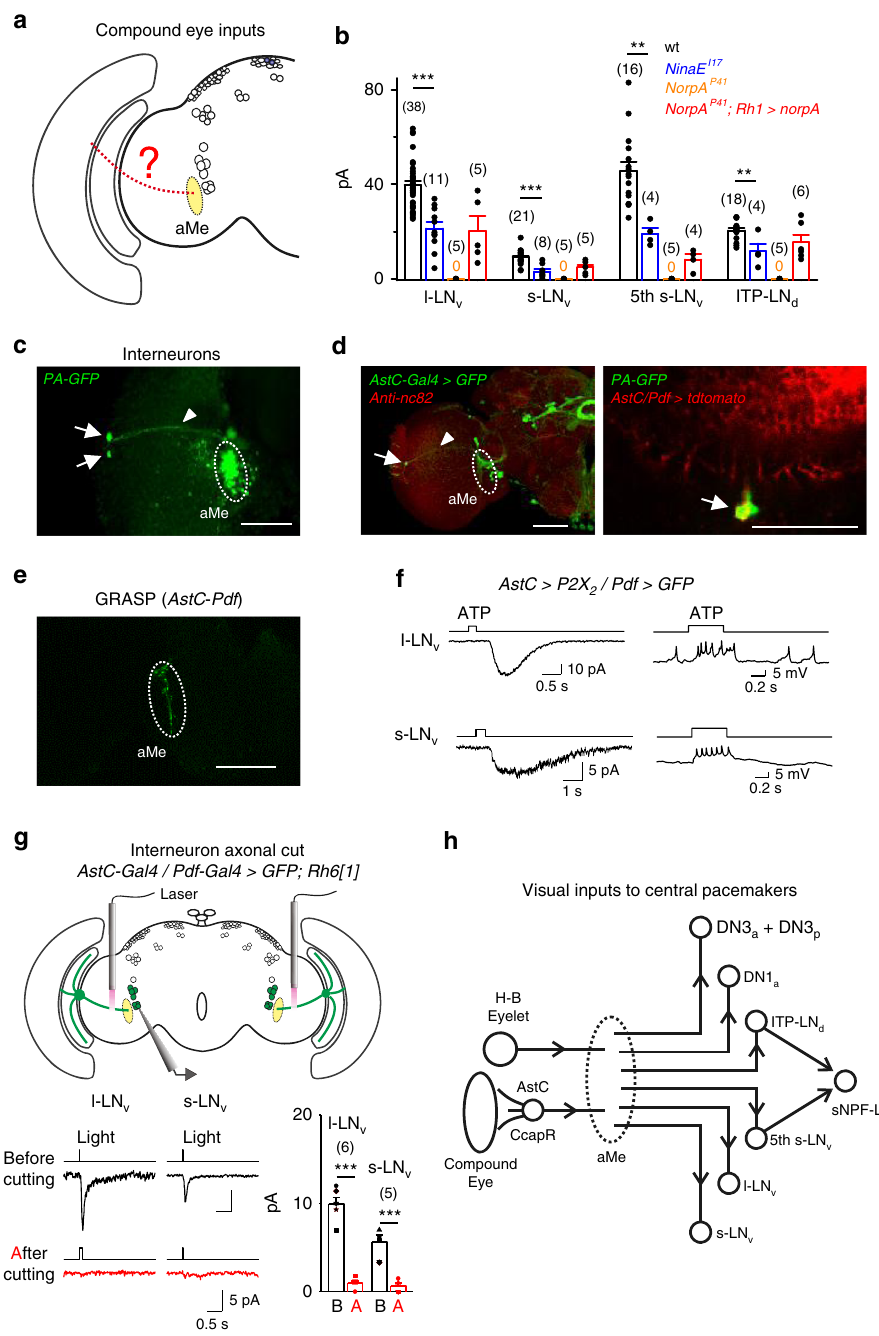
Fig. 7 AstC/CcapR interneurons relay compound-eye inputs to the clock. a Schematic illustration of compound-eye inputs to the central pacemaker neurons. b Collective data of light responses in pacemaker neurons of the different fl ies as indicated. Cell numbers are indicated in brackets; error bars represent SEM; ** P < 0.01; *** P < 0.001. c Interneurons connecting compound eyes to pacemaker neurons. Two interneurons (marked by arrows) are PA- GFP-labeled after two-photon photoactivation of the aMe. d AstC interneuron labels one PA-GFP interneurons. Left, AstC-Gal4 labels one interneuron with similar anatomical features as the PA-GFP-labeled interneurons. Right, overlay of the AstC and PA-GFP labeling. Dashed circles indicate the aMe, arrows indicate the cell bodies, and arrowheads indicate the axons. Scale bar: 50 μ m. e GRASP signals between AstC interneuron and PDF-expressing LNvs. Dashed circle indicates the aMe. Scale bar: 50 μ m. f AstC neuron excites pacemaker neurons. Post-synaptic responses of the l-LNvs (top two traces) and s- LNvs (bottom two traces) to the ATP activation of P2X 2 -expressing AstC neuron. ATP: 2.5 mM. g AstC/CcapR interneurons are required for visual inputs from compound eyes to pacemaker neurons. Top, schematic illustration of axonal cutting by laser and simultaneously patch-clamp recordings of pacemaker neurons. Bottom, light responses of l-LNvs and s-LNvs before and after laser cut of the AstC/CcapR axons (left) and the average results (right). n = 6 and 5 for l-LNv and s-LNv, respectively; error bars represent SEM; *** P < 0.001. h A schematic summary of the circuit connectivity between visual system and central pacemaker